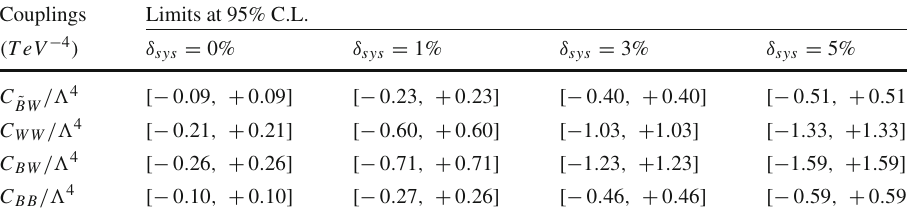
Table 4 Estimated one dimensional 95% C.L. limits on aNTG couplings with and without a systematic error